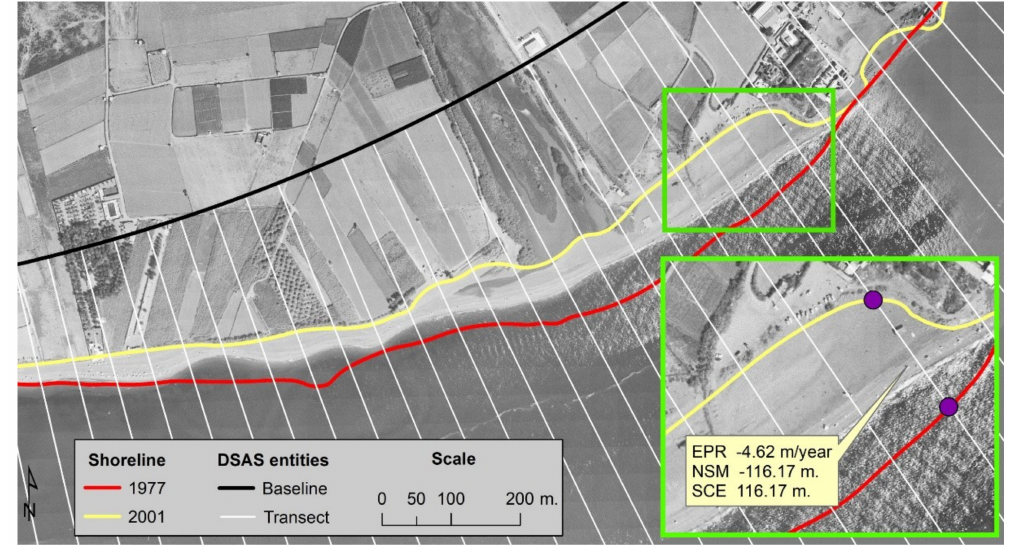
Figure 5. Procedure followed using DSAS tool for calculating erosion rates in the V é lez River Delta (M á laga, Spain) for the period of 1977 to